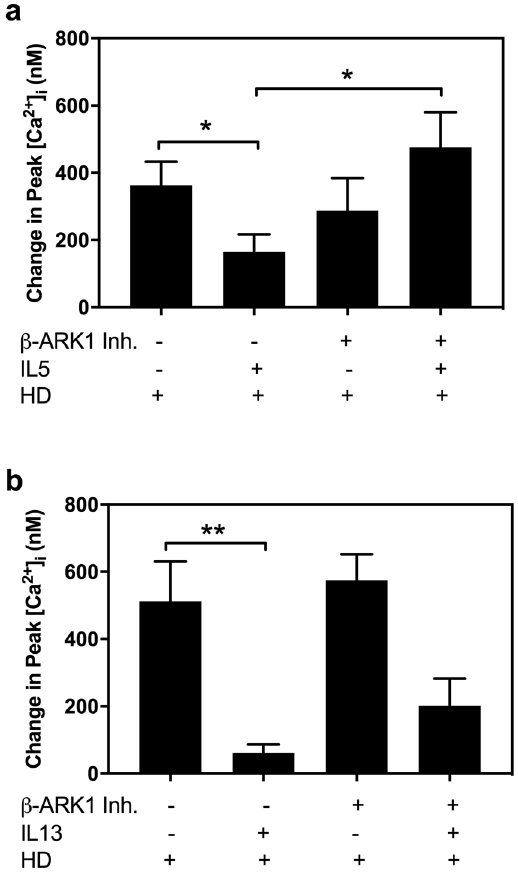
Figure 7. Change in peak [Ca 2 + ] i in rat conjunctival goblet cells. Cells were stimulated with either histamine dimaleate (HD, 10 − 5 M); preincubated with 10 ng/ml IL 5 ( a ) or 10 ng/ml IL13 ( b ) for 30 min prior to addition of the HD; or preincubated with β -adrenergic receptor kinase 1 inhibitor peptide ( β -ARK1 Inh peptide, 10 − 6 M) added 30 min before HD; or preincubated with β -ARK1 Inh peptide, 10 − 6 M, for 15 min prior to addition of 10 ng/ml IL5 ( a ) or 10 ng/ml IL13 ( b ) that were added 30 min before HD. Data are mean ± SEM from eight independent experiments ( a ) or four independent experiments ( b ). * ≤ 0.05; ** ≤